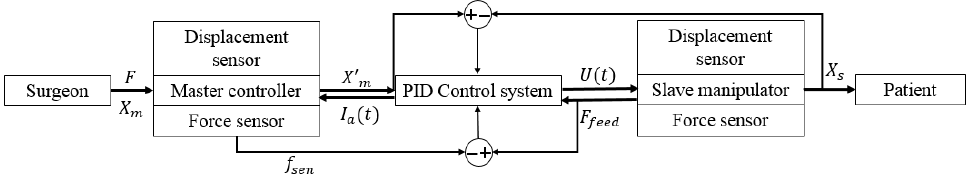
Figure 6. Block diagram of the robot system control strategy.